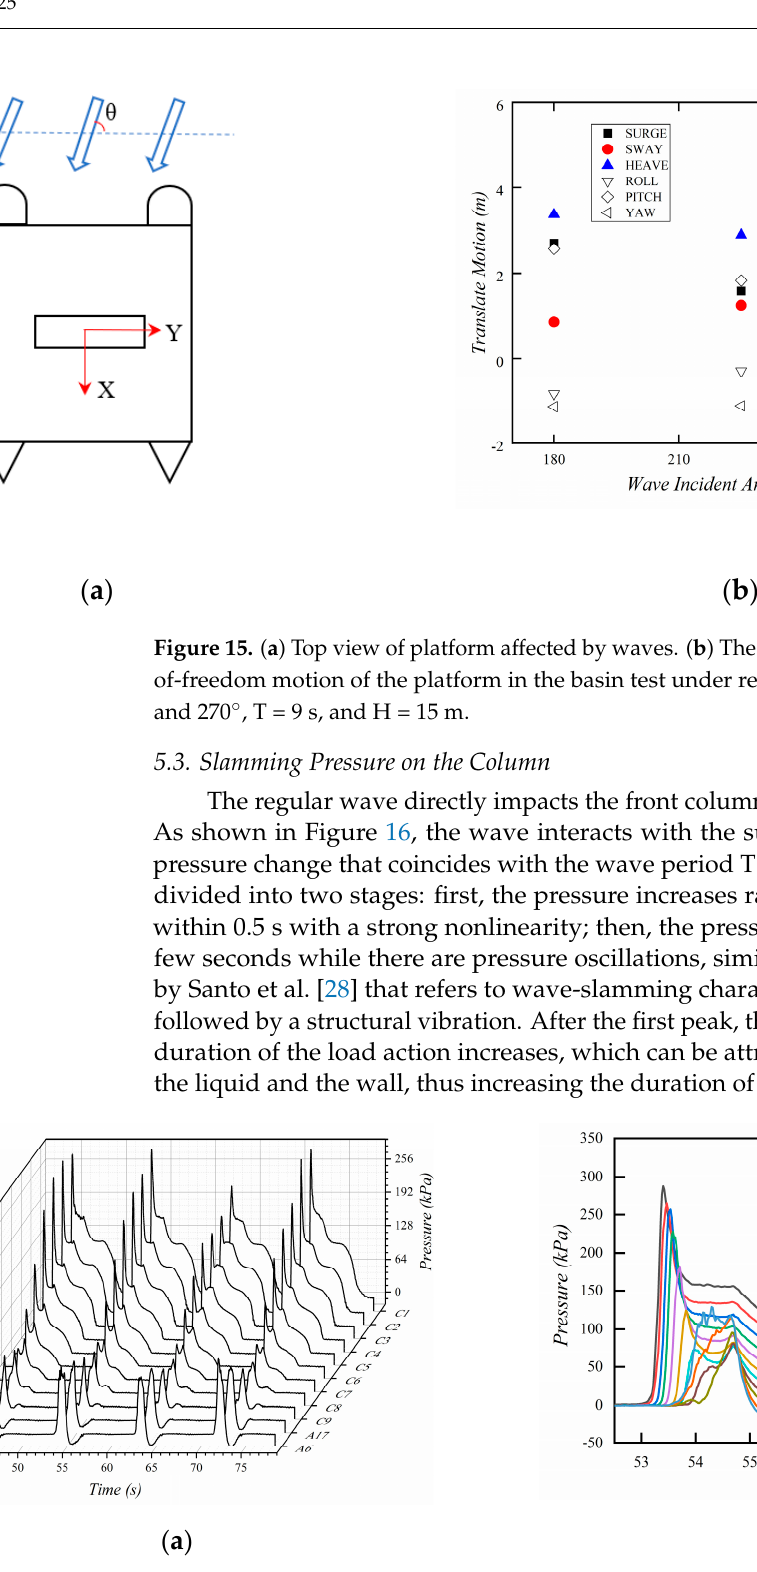
Figure 16. ( a ) Time history of slamming pressure at C1–C9 and A6 and A17 in four periods. ( b ) Time history of slamming pressure at C1–C9 and A6 and A17 in one periods. history of slamming pressure at C1–C9 and A6 and A17 in one